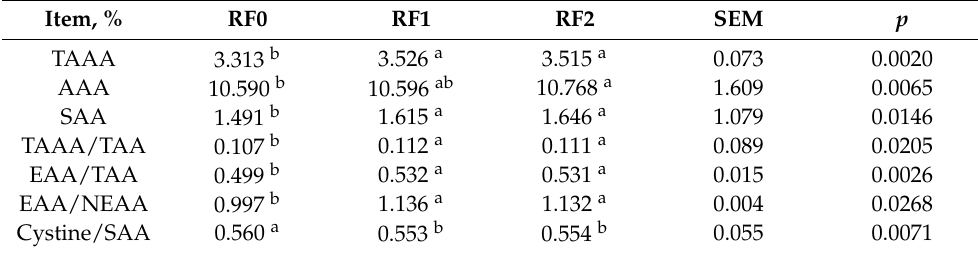
Table 5. Effect of rosehip and flaxseed meals on egg yolk protein quality indices. Item,